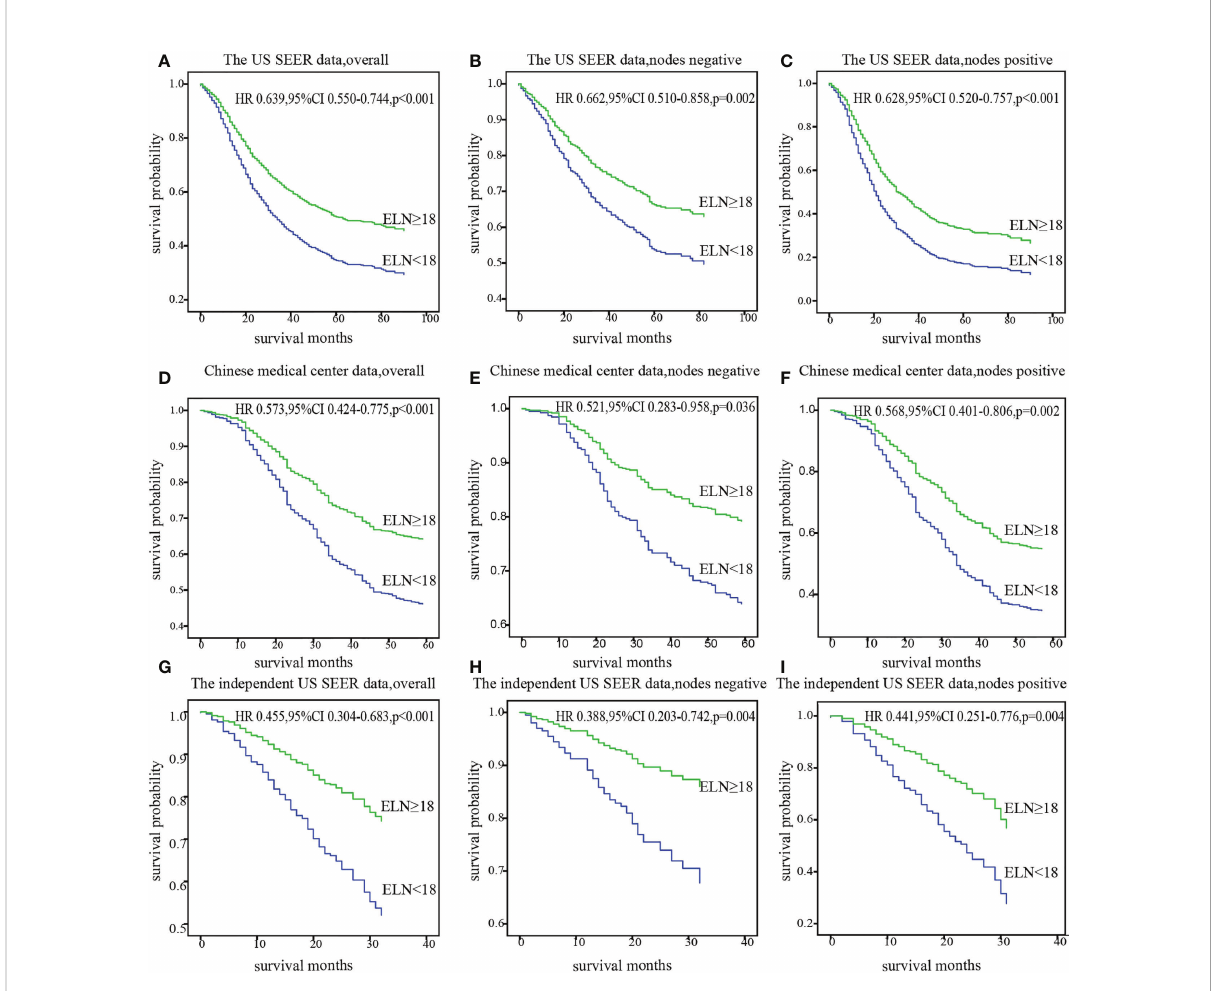
FIGURE 4 Strati fi cation of overall survival with the cut point of 18 ELNs after adjusting for prognostic factors in patients with overall, nodes negative, and nodes positive diseases in the US data (A-C) , Chinese data (D-F) and the independent US data (G-I) . ELN, Examined lymph node; HR, hazard